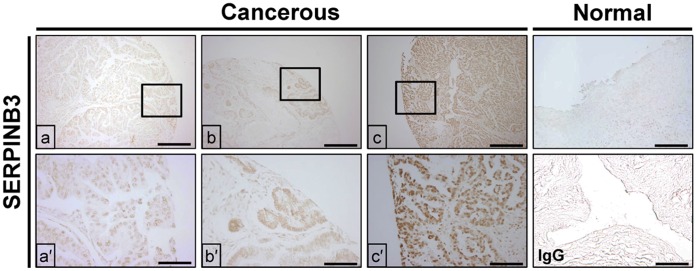
Immunofluorescence microscopy detected SERPINB3 protein in ovarian cancer cell lines of both women and laying hens.[A] SERPINB3 protein was rarely detected in normal cells, but abundant in the nuclei of chicken ovarian cancer cells. [B] SERPINB3 protein was expressed in nuclei of human OVCAR-3, SKOV-3 and PA-1 cells. Cell nuclei were stained with DAPI (blue). All images were captured at 40X objective magnification.